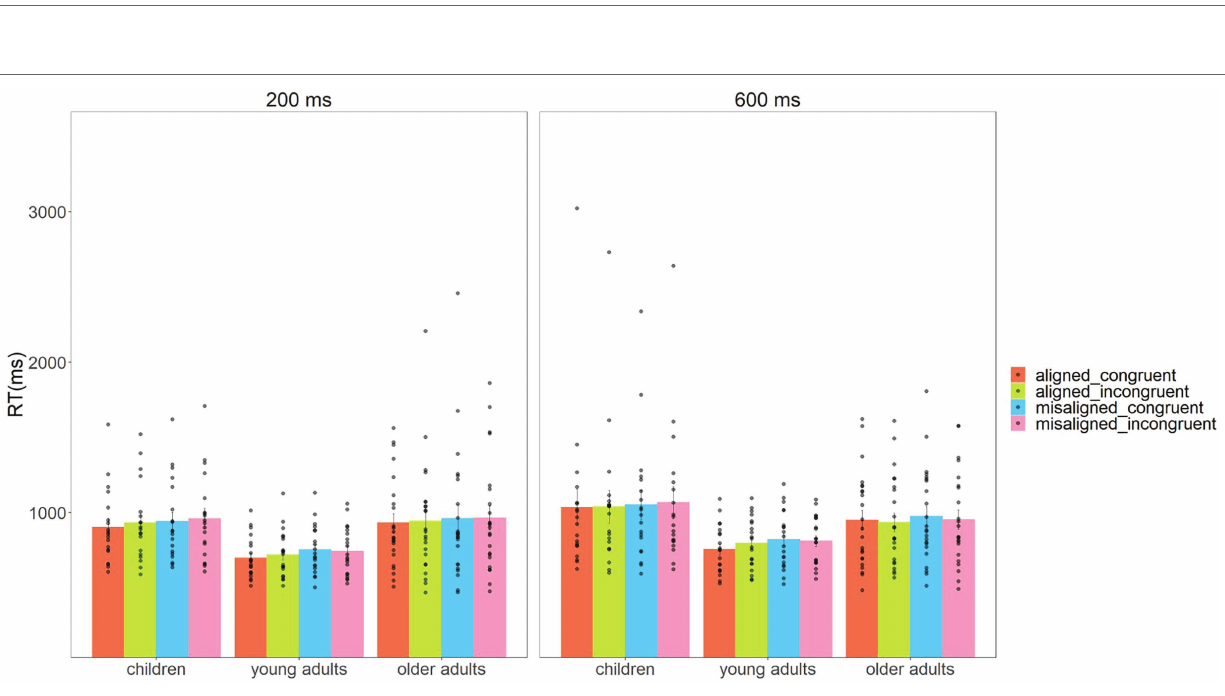
FIGURE 3 | Mean response time (RT) and standard errors for alignment, congruency, and stimulus presentation duration as a function of children, young adults, and older